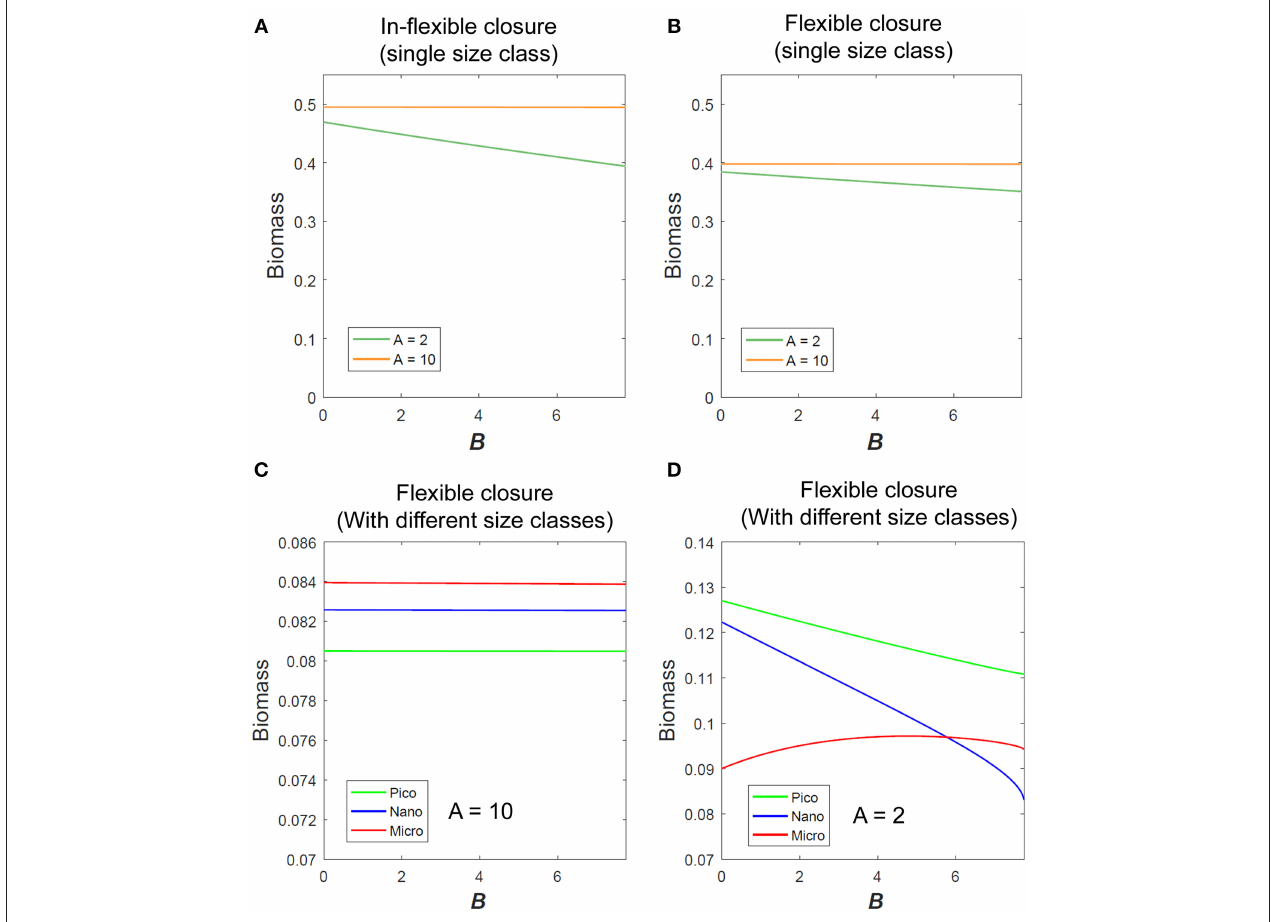
FIGURE 2 | Variation of phytoplankton biomass with micro-scale variability using (A) In-flexible model and (B) Flexible closure model in eutrophic ( A oligotrophic conditions ( A 2) as obtained for single size class of phytoplankton. Variation of different size classes of phytoplankton biomass (considering competition = between them) with micro-scale variability in (C) eutrophic and (D) oligotrophic condition. 2016b; Vallina et al., 2017; Acevedo-Trejos et al., 2018;